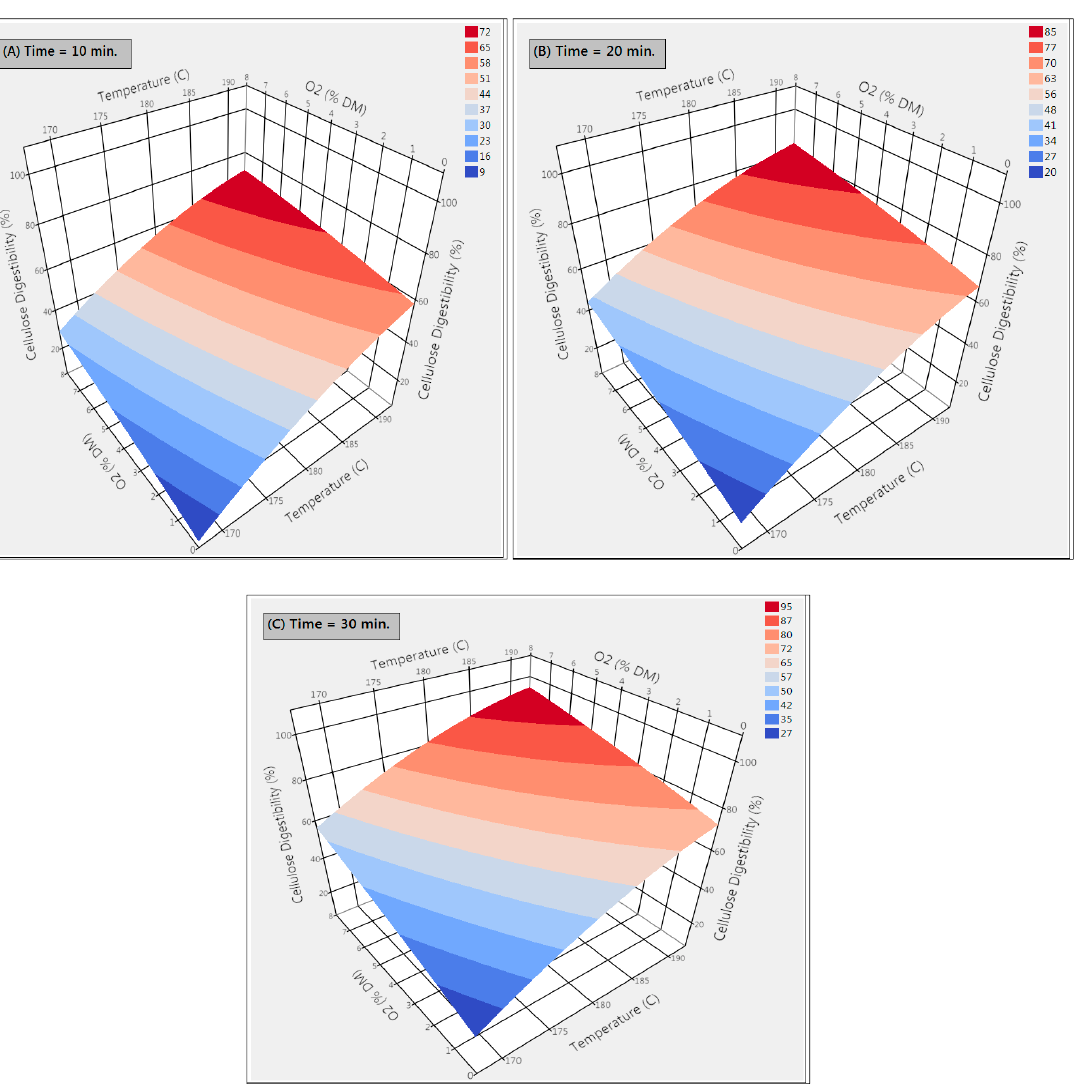
Figure 2. Response surface plots, showing the influence of temperature and residence time on cellulose digestibility (%) after enzymatic hydrolysis of pretreated poplar sawdust at di ff erent residence times; ( A ) residence time 10 min; ( B ) residence time 20 min; ( C ) residence time 30